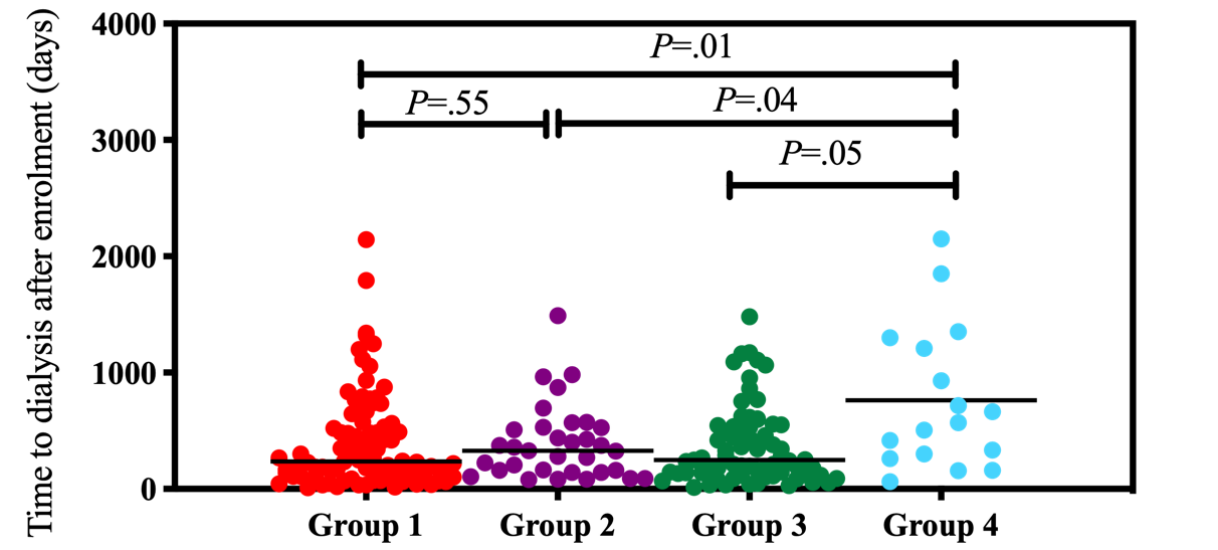
Figure 1. Trends in time to dialysis were compared between the four groups. The lines indicate median values. Statistical calculation of P values was performed using the nonparametric Mann-Whitney U test.